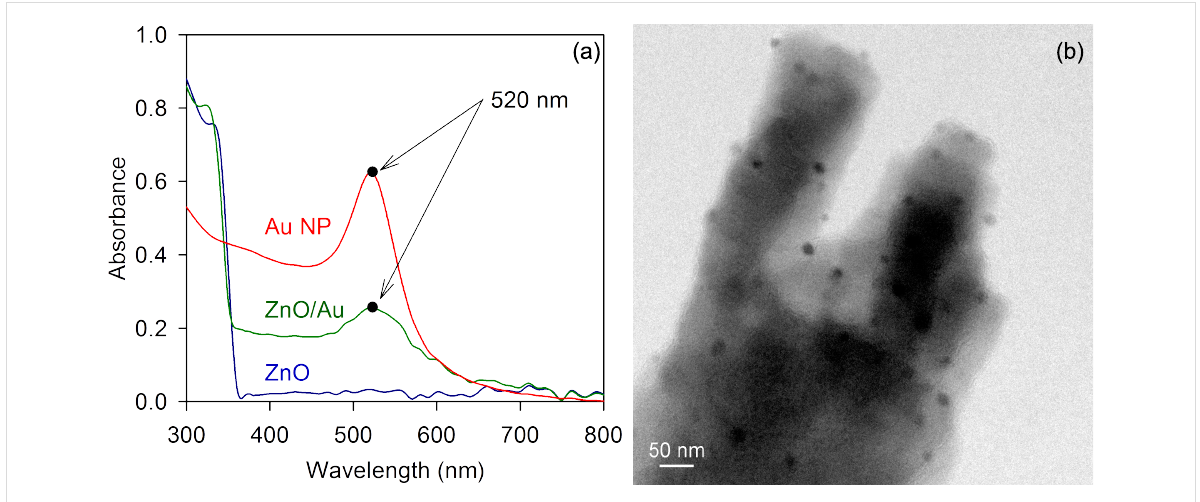
Figure 2: (a) Optical absorption of ZnO nanorods, ZnO/Au-nanocomposite photoelectrode and Au-nanoparticle colloid (particle size ~20 nm) and (b) TEM image of Au nanoparticles in situ deposited on the surface of a ZnO nanorod.